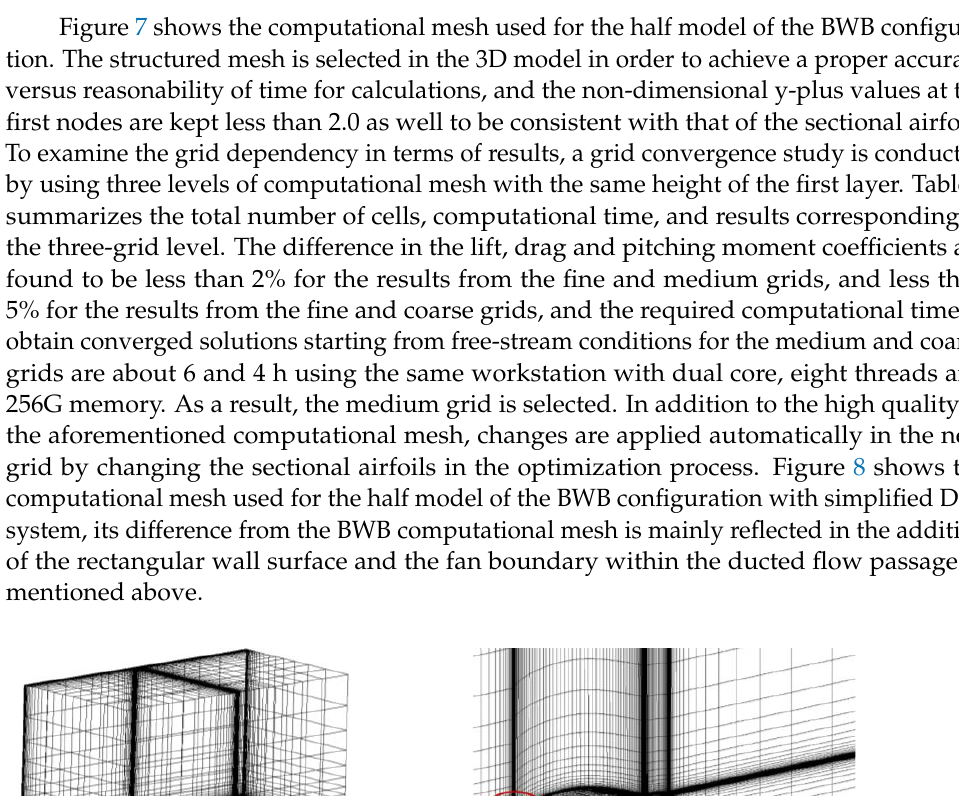
Figure 6 . Computational mesh around the baseline airfoil at section A. ( a ) Computational domain. ( b ) Near-wall grids distribution.